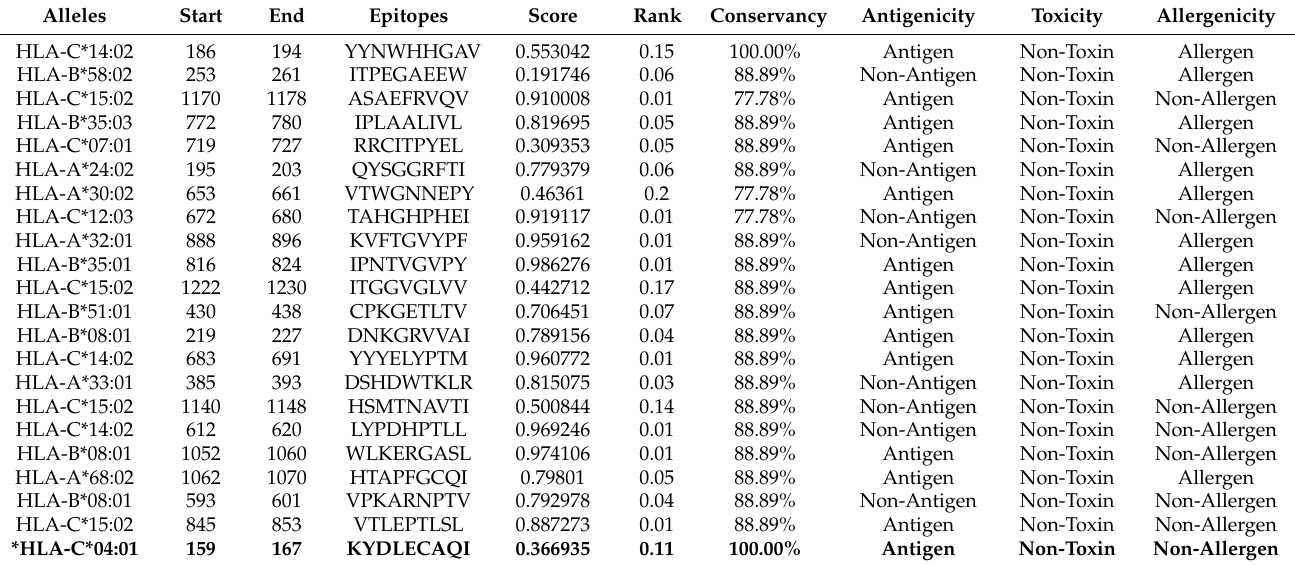
Table 1. Analysis of MHC-I binding T-cell